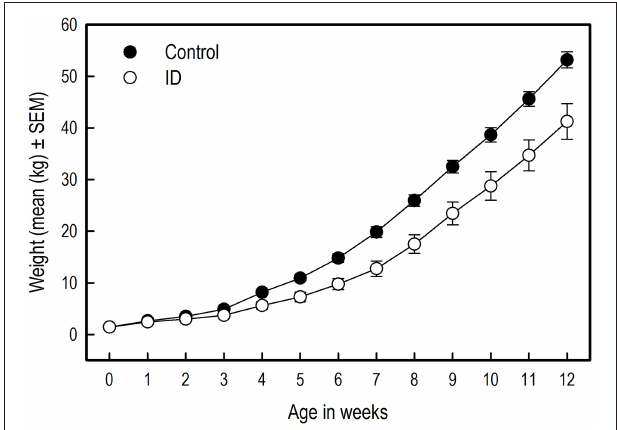
FIGURE 3 | The body weights of ID ( n = 8 ) and control ( n = 10 ) piglets in kilograms over the course of the experiment. The difference in body weights between treatment groups was significant from week 3 onward (week 3: p = 0.03 ). Note: The absence of error bars indicates that the SEM is smaller than the plot